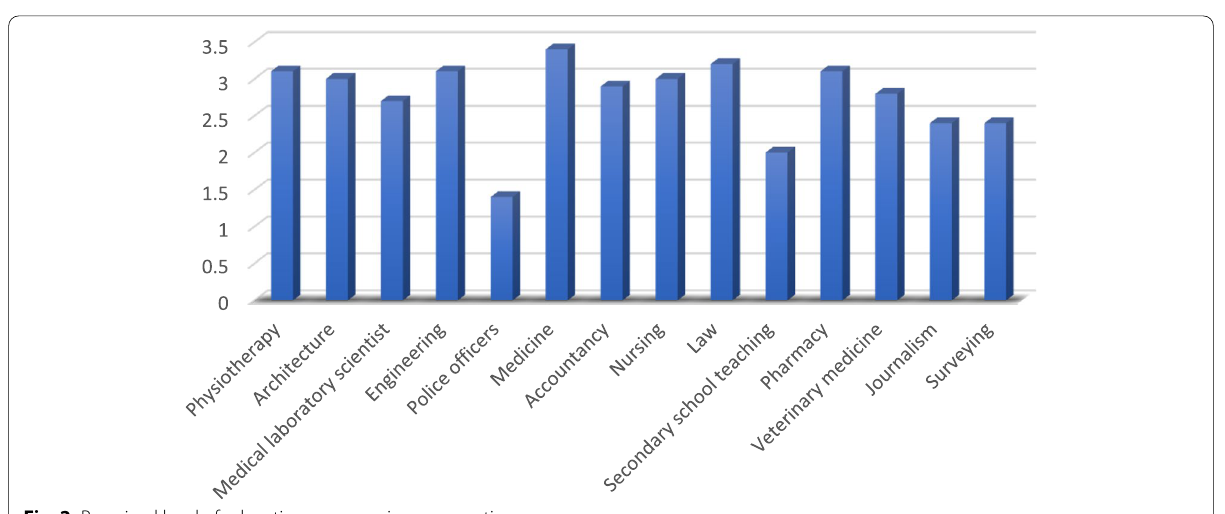
Fig. 2 Perceived level of education across various